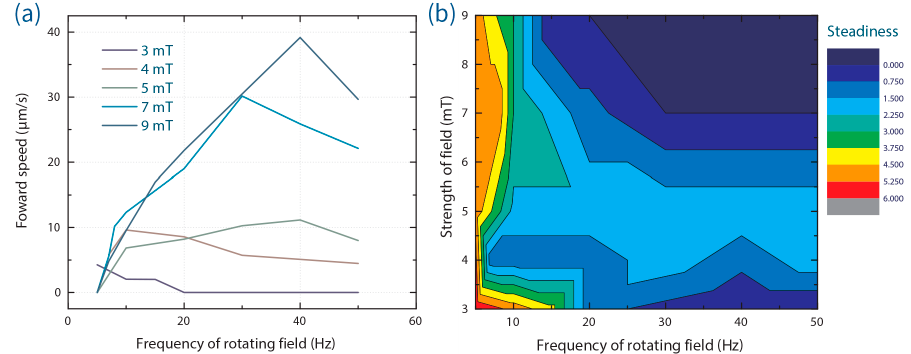
Figure 5. Swimming characterization in FC-40 oil (containing 3% w / w PFPE-PEG-PFPE tri-block surfactant) along a 100 µm deep PDMS chamber. ( a ) Forward swimming speed of ABFs as a function of magnetic field strength and rotation frequency. ( b ) Evaluation of the steadiness of swimming. Here, higher values represent reduced “steadiness”. “Wobbling” and “shifting” are two deleterious factors used to assay the swimming performance of ABFs (the assay methodology is provided in Appendix 4). The combination of these data provides the range of operational parameters that deliver stable swimming performance.